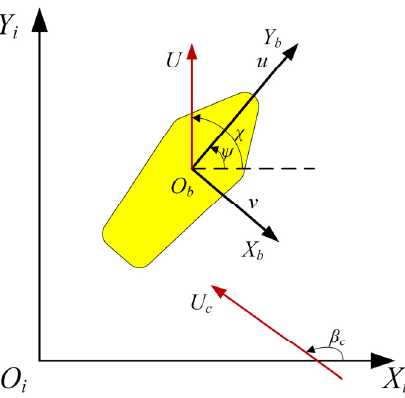
Figure 1. Diagram of USV motion under fixed current field disturbance.